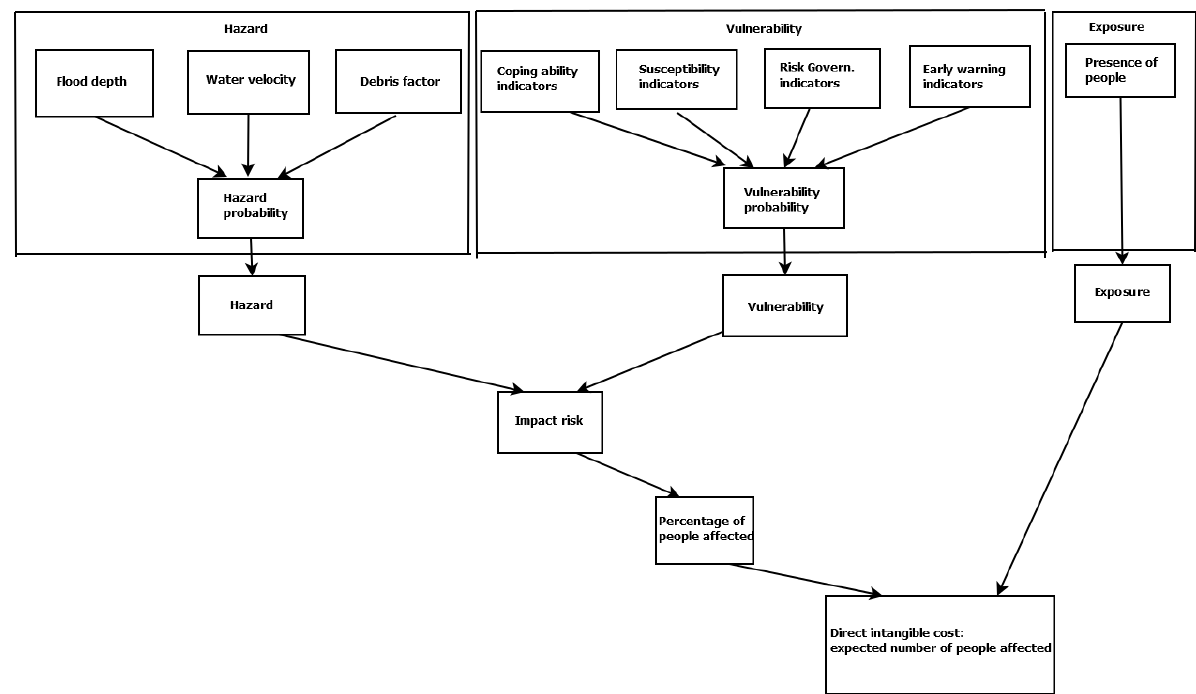
Figure 2. Customised application of the risk framework by including an early warning system (some information derived from the original framework developed by